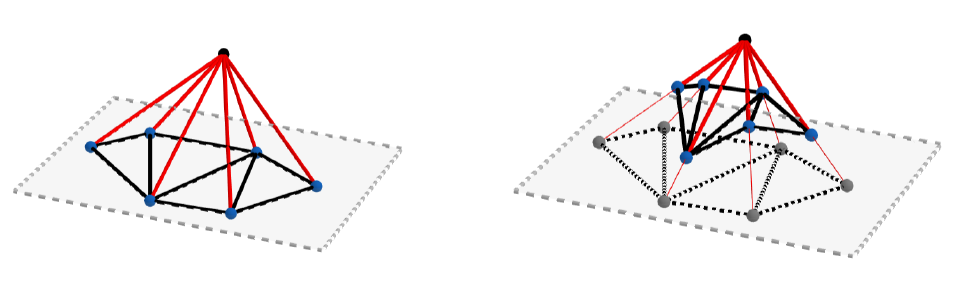
Figure 11. Coning and moving vertices radially in and out on the cone rays does not change infinitesimal